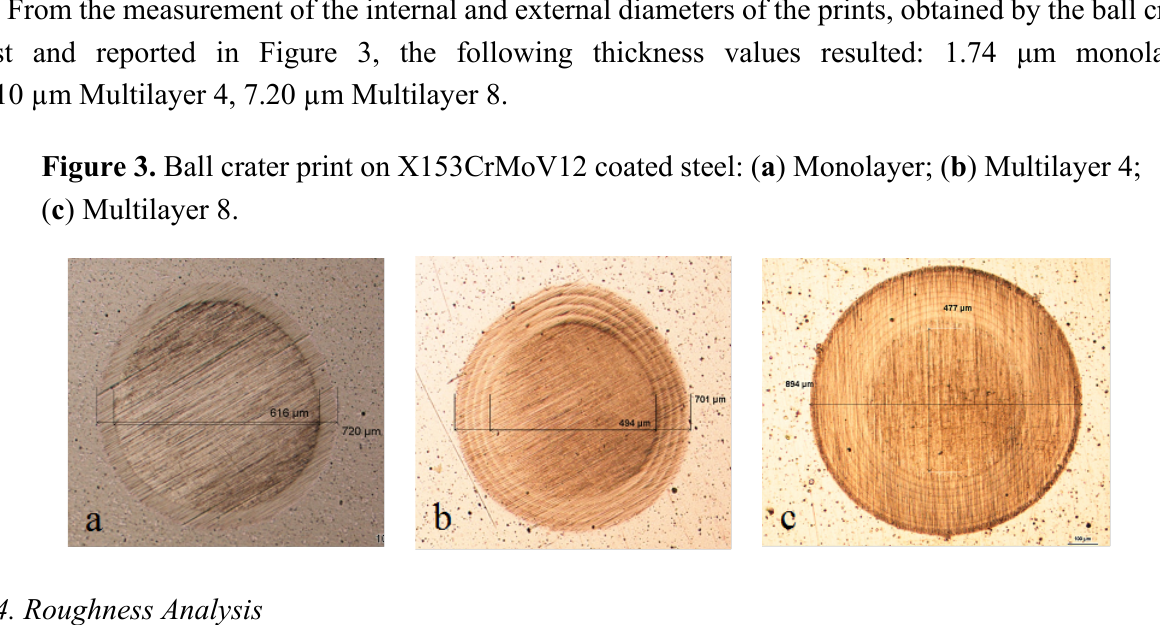
Table 1. Average roughness values ( R